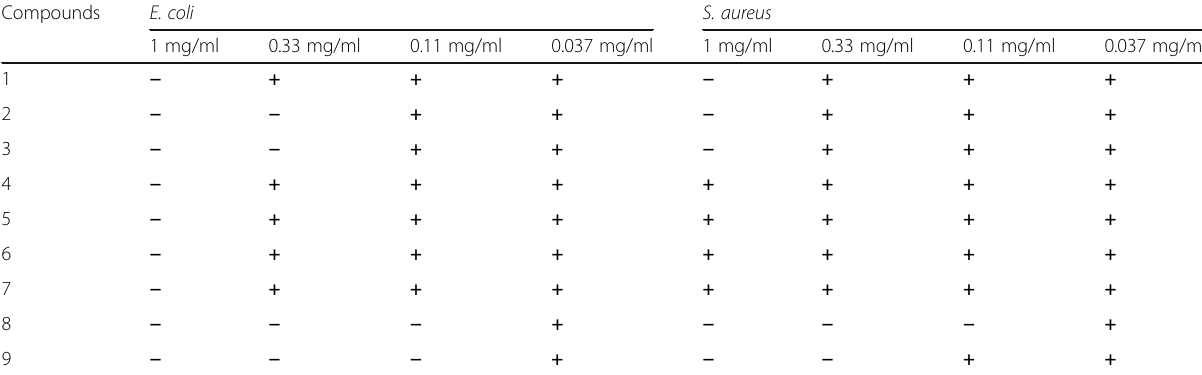
Table 2 Antibacterial activities of compounds 1 – 9 against E. coli and S. aureus